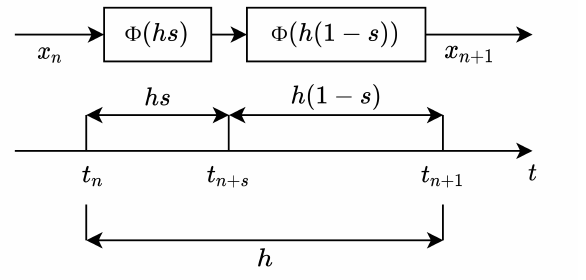
Figure 1. One integration step of the semi-implicit method with variable